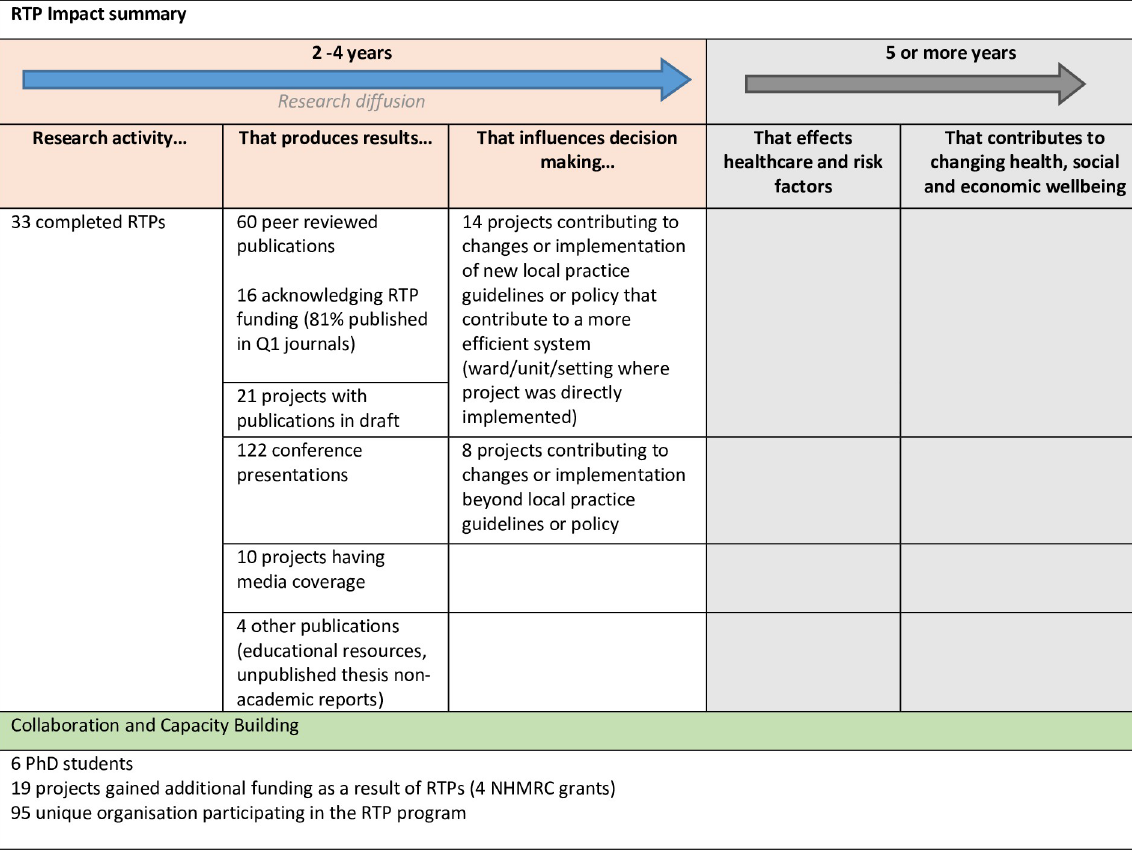
Fig 1. Summary of research impact of the RTP program. (Adapted from https://www.cahs-acss.ca/wp-content/uploads/2011/09/ROI_ FullReport.pdf).